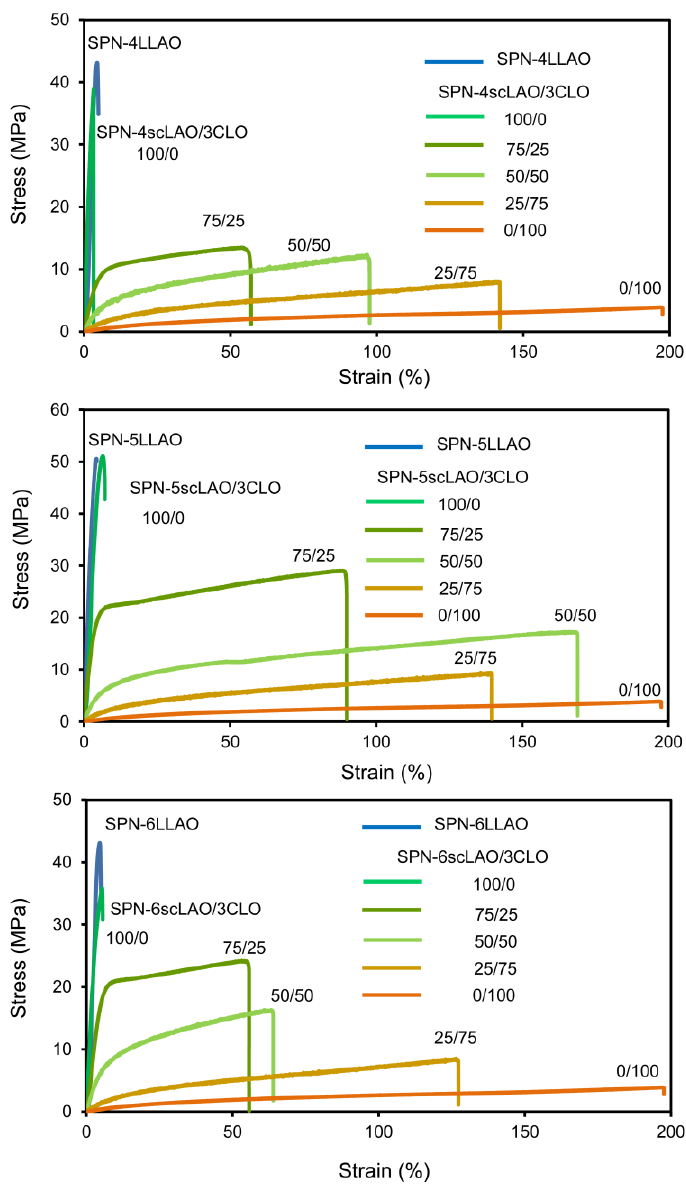
Figure 9. Stress-strain curves of SPN- m scLAO/3CLOs (100/0, 75/25, 50/50, 25/75 and 0/100) and SPN- m LLAOs ( m = 4, 5 and 6).